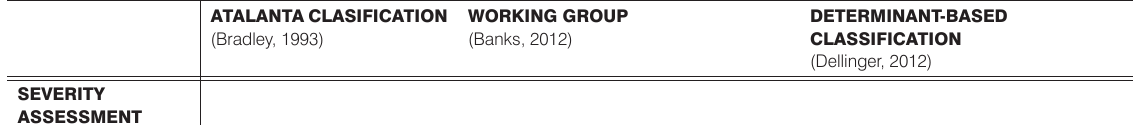
Table 1. Differences among classification